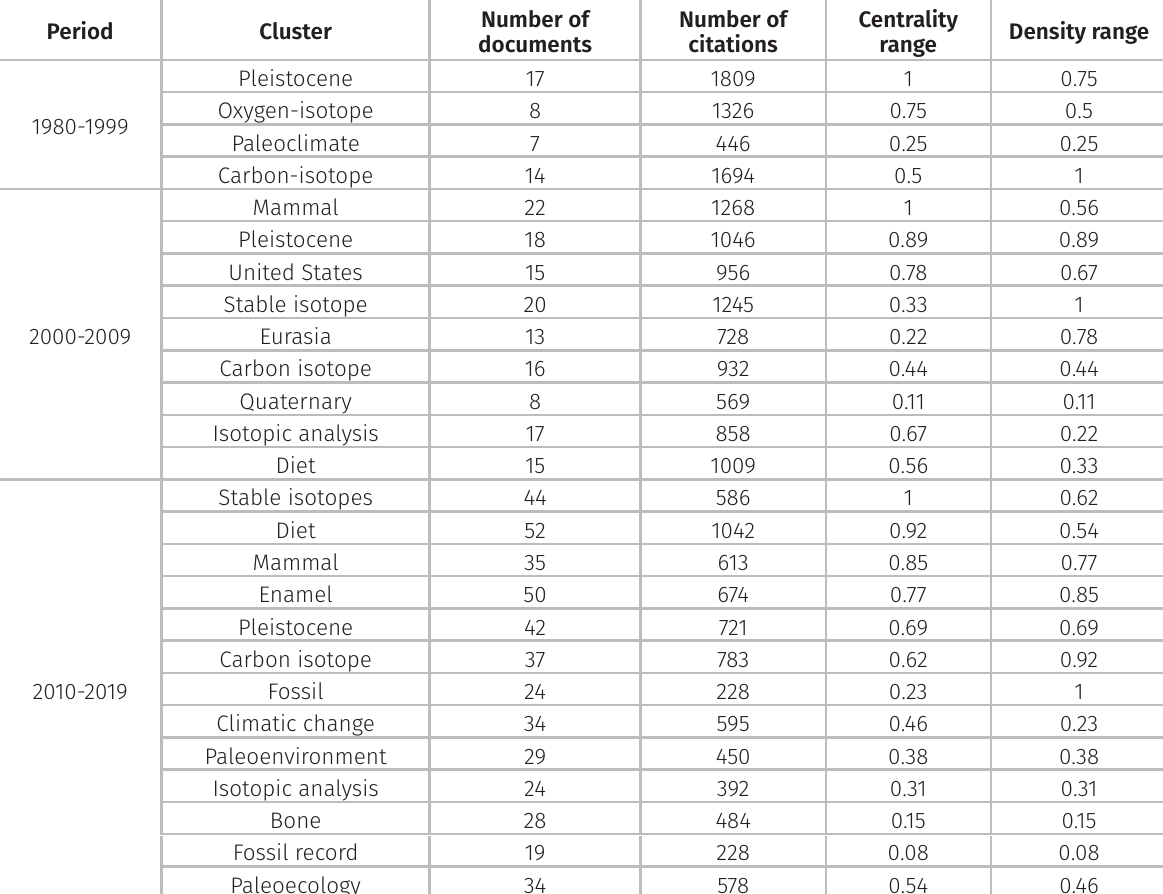
Table IV. Most ranked themes per period and respective number of documents in which they are mentioned, number of citations received, and centrality and density values.